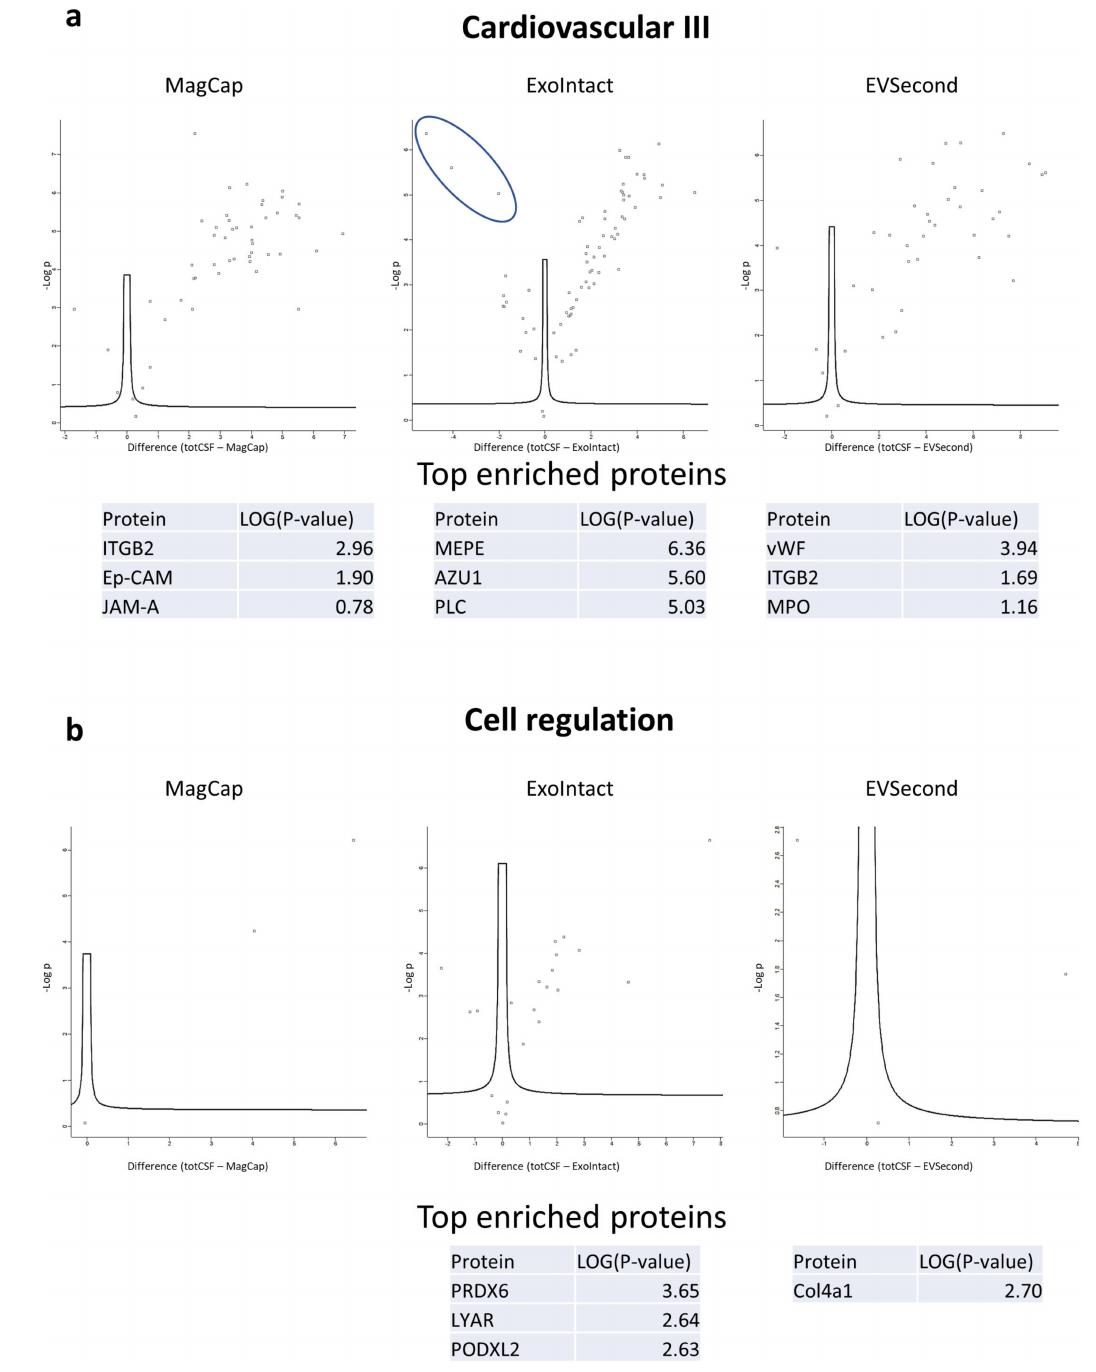
Figure 7. Volcano plots comparing EV samples to total CSF samples. Volcano plots indicate the fold-change di ff erences on the horizontal axis and the p -value (double-sided t -test with a false discovery rate of 0.05). The plots represent data from the cardiovascular III panel ( a ) and from the cell regulation panel ( b ). The top three enriched proteins are listed. The blue circle in the top middle panel indicates the top three enriched proteins. Tot CSF: total CSF, MagCap: